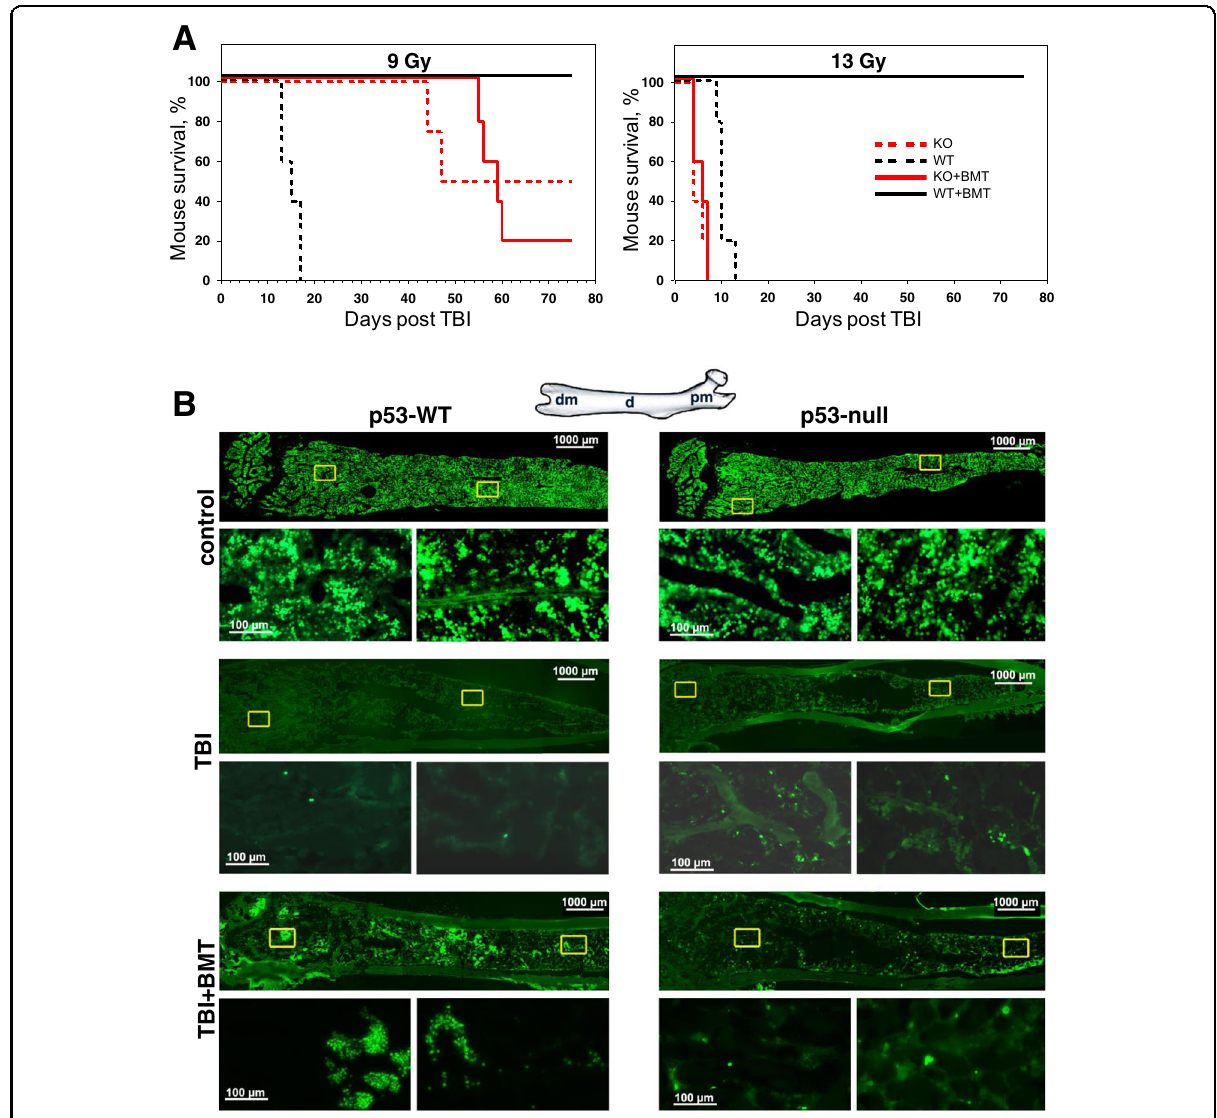
Fig. 1 Successful BMT after IR preconditioning in mice requires p53 expression by the host. A BMT fails to rescue lethally irradiated p53-null mice. Groups of p53-knockout (p53-KO) and p53-WT male C57BL/6 mice were irradiated with lethal doses of TBI (9 or 13 Gy; n = 7 – 10 mice/group at each TBI dose) without or with transfusion of p53-WT BM cells (5 × 10 6 cells/mouse; BMT) 24 h later. The survival of mice was monitored daily for 60 – 75 days. Representative results from one of three independent experiments are shown. The difference in survival between p53-WT and p53-KO mice transplanted with p53-WT BM was statistically signi fi cant ( P < 0.01 by two-tailed Fisher ’ s exact test) beginning 7 and 60 days after 13 and 9 Gy TBI, respectively. B After IR and BMT, clusters of EdU + proliferating cells are present in the BM of p53-WT mice but not in the BM of p53-null mice. Longitudinal sections of femoral BM from p53-WT and p53-null mice were stained to detect EdU incorporation (green fl uorescence). p53-WT and p53-null mice were left untreated (control; upper panel), irradiated (13 Gy; middle panel), or irradiated and then given p53-WT BMT 24 h later (13 Gy + BMT; bottom panel). Mice were killed and femurs collected 5 days after IR and 1h after intraperitoneal injection of EdU (10 mg/kg mouse body weight). A diagram of a femur is shown in the upper left corner of the fi gure: dm-distal metaphysis, d-diaphysis, pm-proximal metaphysis. Representative results from three mice of each phenotype/treatment group are shown. Two boxed areas from each low magni fi cation (×2.5) image are shown immediately below at higher magni fi cation